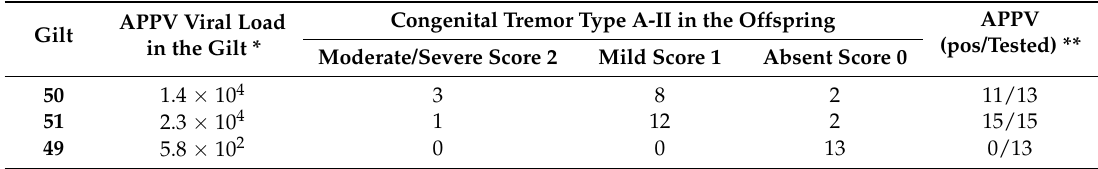
Table 2. Congenital tremor type A-II in litters from APPV-infected